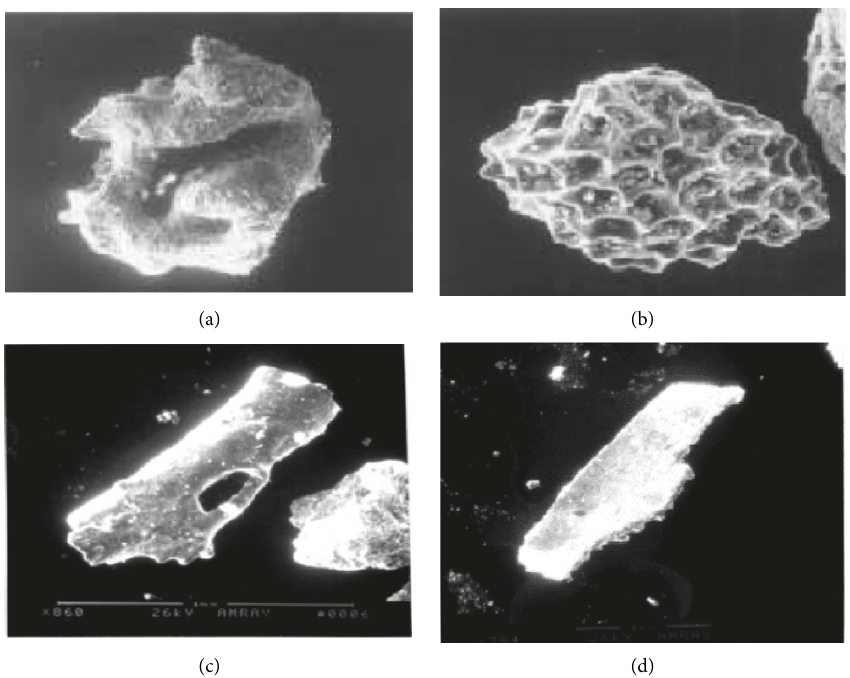
Figure 2: Typical shape of calcareous sand [4]: (a) lump-shaped; (b) spindle like-shaped; (c) flaky-shaped; (d)